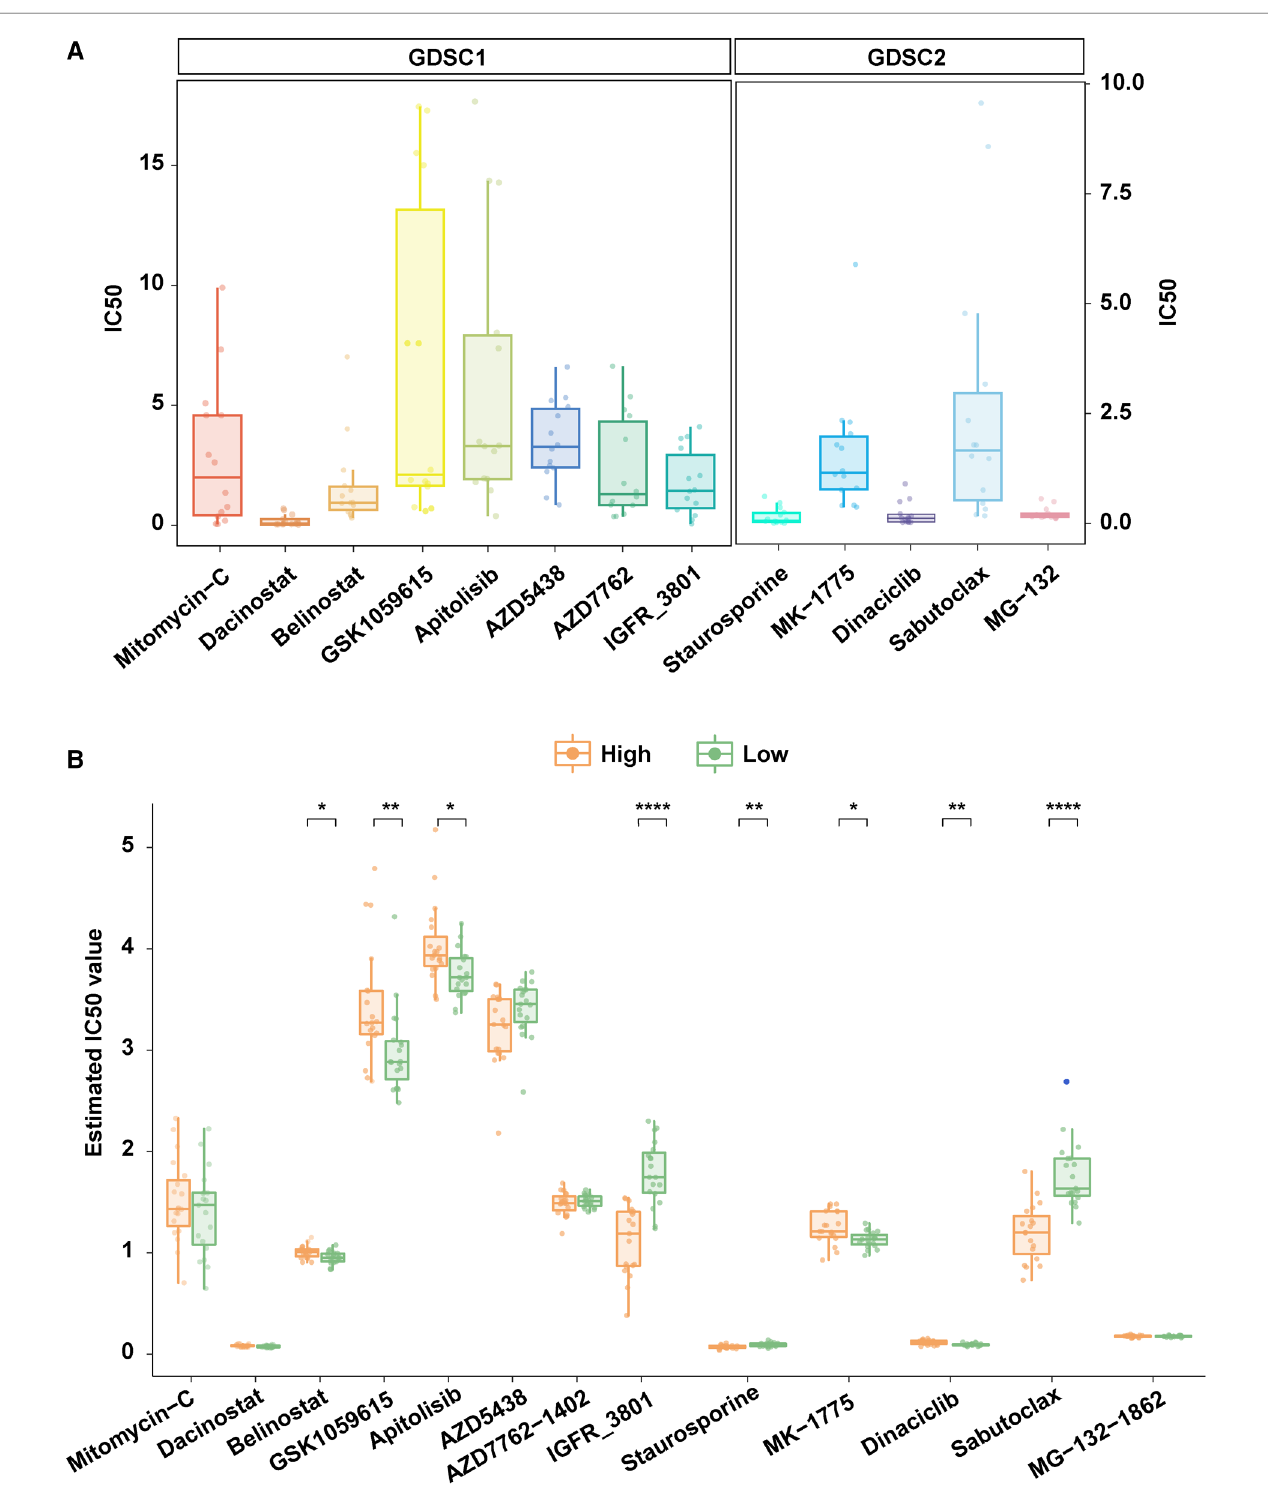
FIGURE 6 Exploration of potential therapeutic agents for patients with high risk. ( A ) TP53 mutant COAD cell lines were sensitive to multiple anti-tumor agents in the GDSC database. ( B ) Comparison of the IC50 of anti-tumor agents that were TP53 mutant COAD cell lines sensitive in high risk and low risk